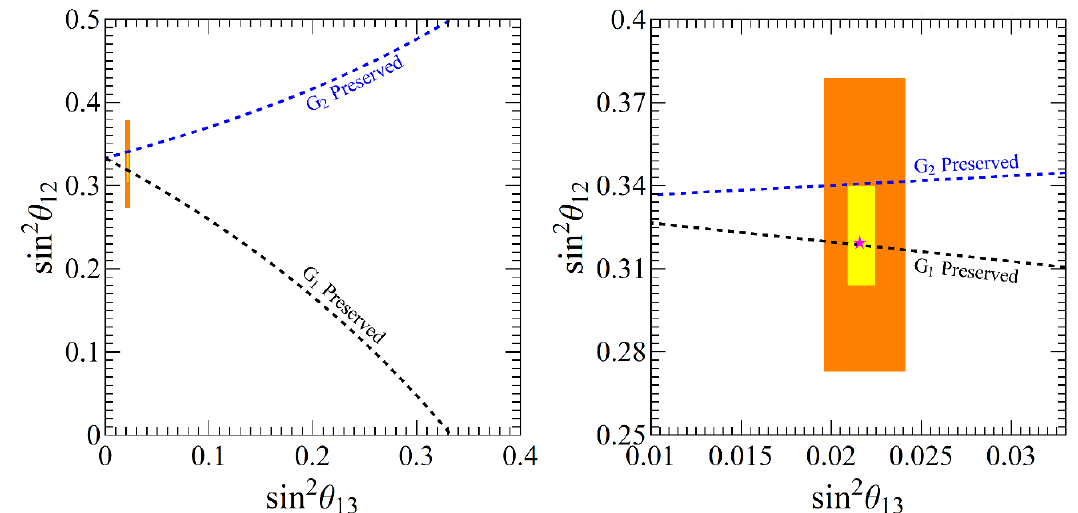
Figure 1 . Relating solar and reactor angles: predicted correlation between sin 2 (cid:18) 12 and sin 2 (cid:18) 13 . The black dashed line corresponds to the case where G 1 is preserved by the neutrino sector (eq. (4.15), left), while the blue dashed line refers to the case where G 2 is preserved by the neutrino sector (eq. (4.34), left). The right panel is a zoom of the left one. The shaded regions represent the current 1 (cid:27) and 3 (cid:27) ranges for the case of normal ordering [6].